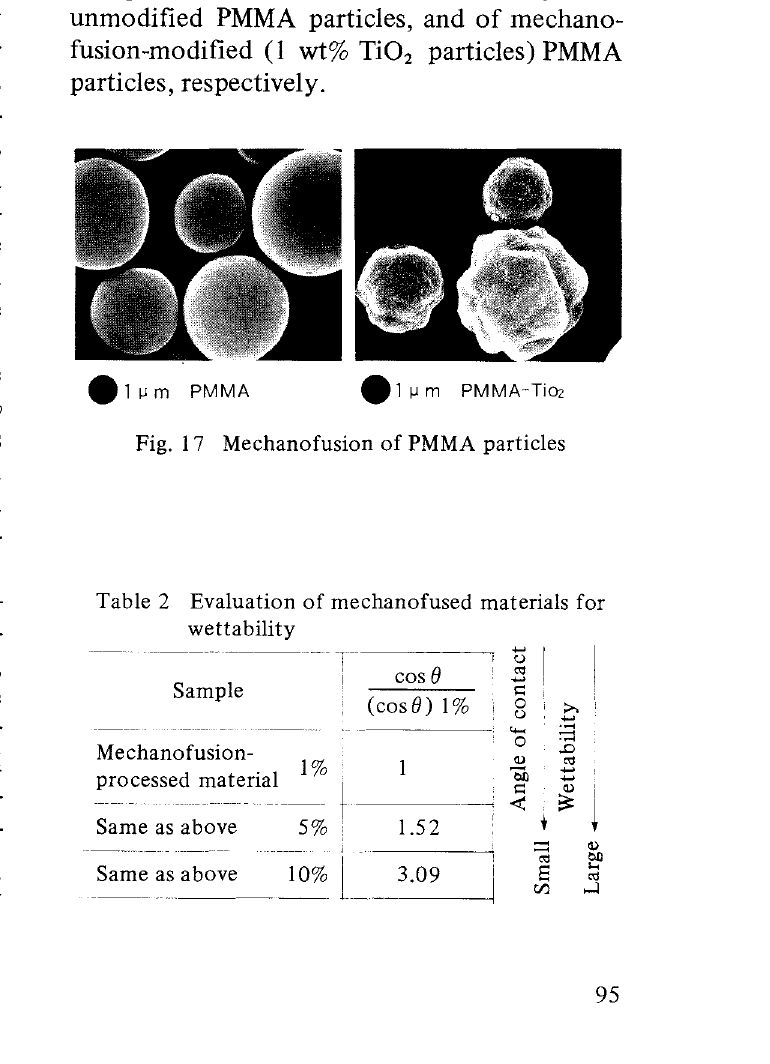
Fig. 16 The penetration ratio measurement with mechanofusion-processed materials